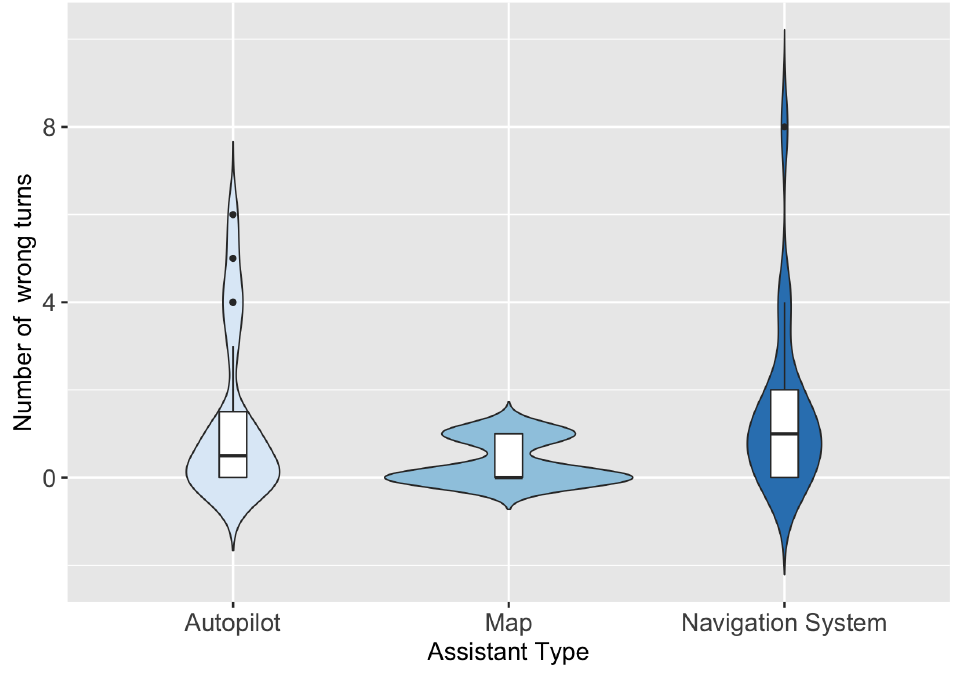
Figure 6. Distribution of the number of wrong turns for the different assistant types. Black dots represent